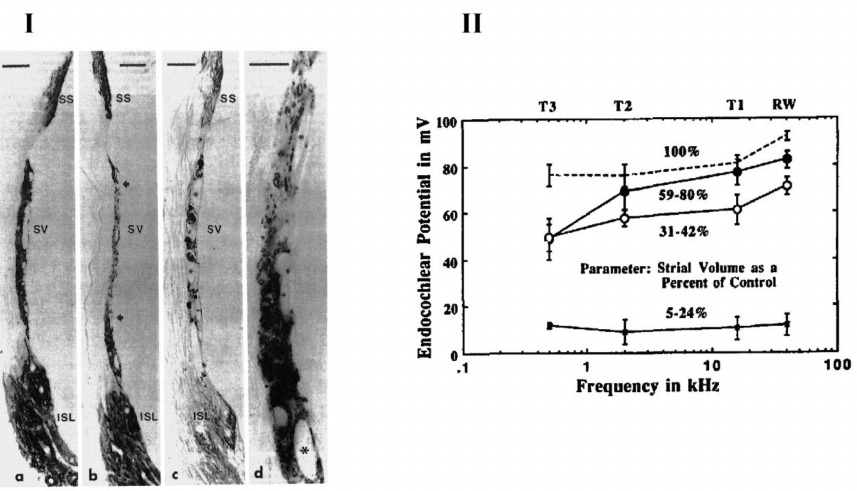
Figure 3. Na, K-ATPase expression in the cochlear lateral wall and endocochlear potential recordings for different age-group gerbils. ( I ) Middle turn sections of gerbil cochlea showing the Na, K-ATPase staining for a 6-month-old gerbil (a) and a 36-month-old gerbil (b–d). Various parts of lateral wall were stained for Na, K-ATPase expression; marginal cells in stria vascularis (SV), fibrocytes in the suprastrial zone (SS) and the inferior spiral ligament (ISL). There was a reduction in NA, K-ATPase immunostaining in the central portion of the SV (b—between arrows) as well as fibrocytes in the SS zone and ISL (c). Higher magnification of strial atrophy in part (b) is depicted in part (d). Strial capillaries (asterisks) were present in old age gerbil cochlea and remain patent (c and d). Scale Bars: a, b, c = 20 µ M and d = 10 µ M. Magnifications: a, b and c = × 800 and d = × 1800. ( II ) Mean values of endocochlear potentials of nine young animals (dotted line) and three groups of 35- to 38-months-old animals. The measurements were done at four positions—round window and three turns; T1, T2 and T3. Old animals were grouped based on the percentage of Na, K-ATPase immunostaining remaining as compared to the young adult control group. From Schulte and Schmiedt (1992) [118], with permission from the